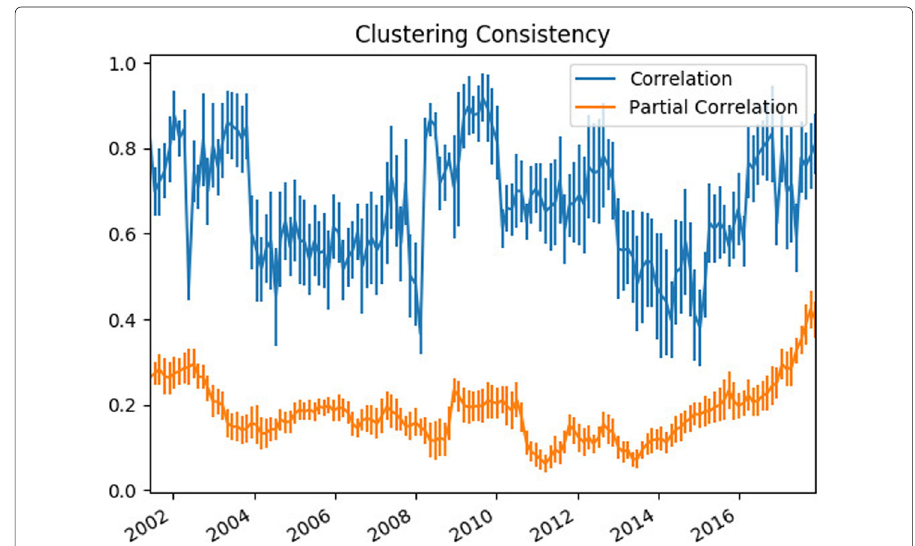
Fig. 13 Clustering Consistency for the Louvain algorithm over time. The correlation network produces much more stable clusters than the partial correlation networks, although there is much more variance in this consistency than in the partial correlation